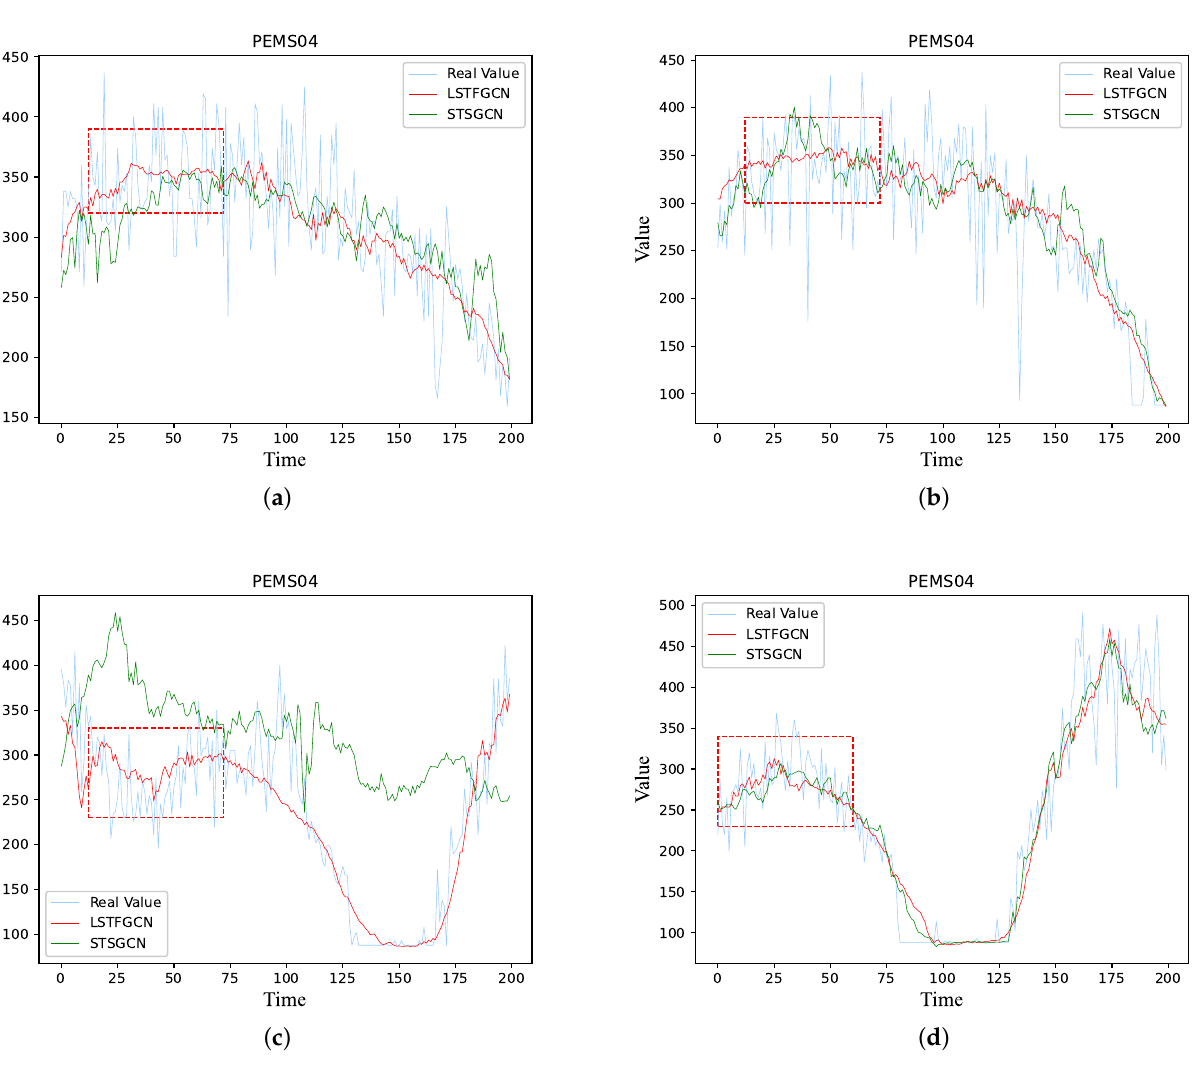
Figure 9. Comparison of prediction results of LSTFGCN and STSGCN in four random test cases ahead of Horizon 12 on PEMS04